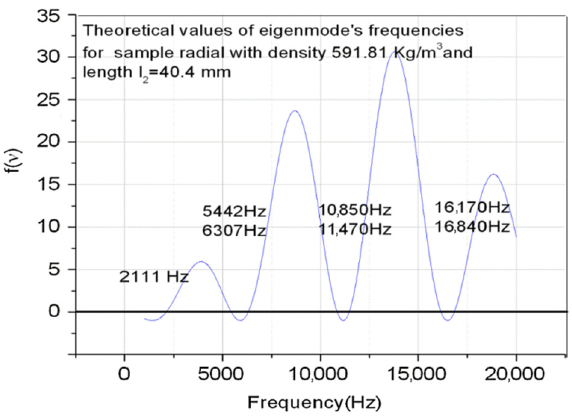
Figure 1. Fourier spectrum and the eigenmodes frequencies.